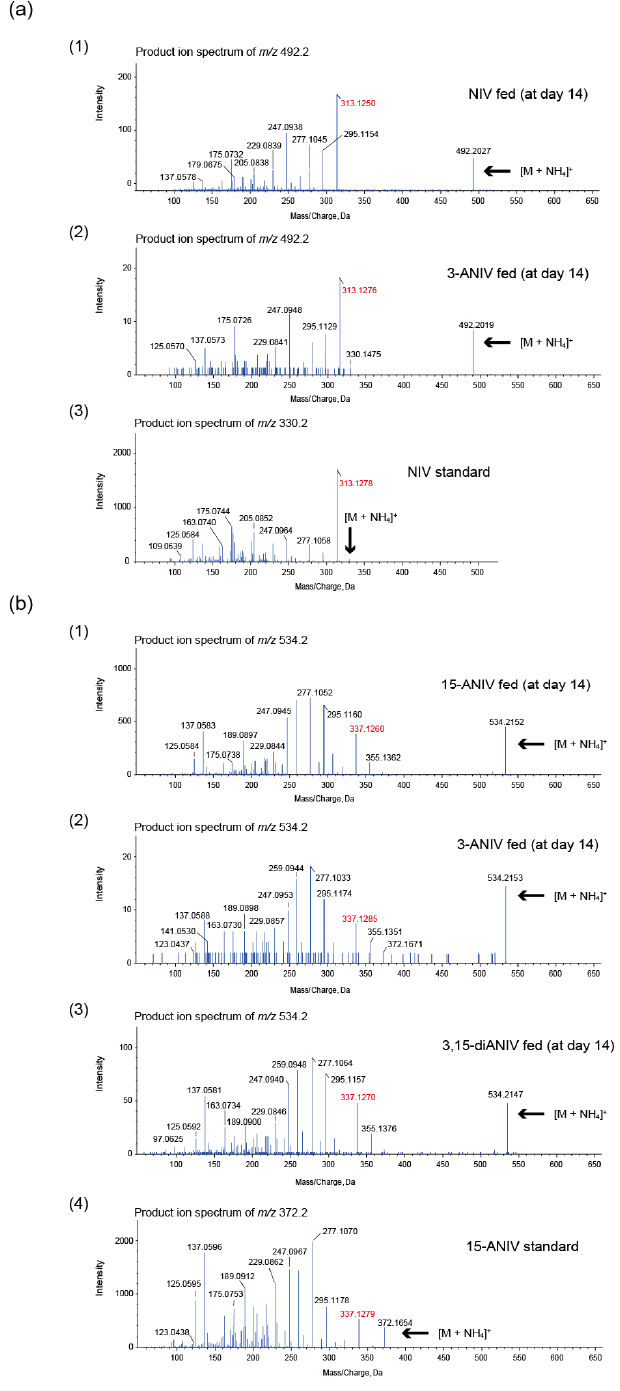
Figure 6. LC–MS/MS analysis of the transformed products of nivalenol (NIV)-type trichothecenes by FGD5/101. The transformed trichothecenes were analyzed 14 d after the feedings. The ammonium adduct ion of each transformed metabolite is shown. ( a ) MS/MS analysis of hexose-conjugated NIV obtained by feedings of NIV (panel 1) and 3-acetylnivalenol (3-ANIV) (panel 2). The spectrum of [NIV (C 15 H 20 O 7 ) + NH 4 ] + (theoretical m / z of 330.1547) (panel 3) is shown as a reference for comparison. ( b ) MS/MS analysis of hexose-conjugated 15-ANIV obtained by feedings of 15-acetylnivalenol (15- ANIV) (panel 1), 3-ANIV (panel 2), and 3,15-diacetylnivalenol (3,15-diANIV) (panel 3). The spectrum of [15-ANIV (C 17 H 22 O 8 ) + NH 4 ] + (theoretical m / z of 372.1653) (panel 4) is shown as a reference for